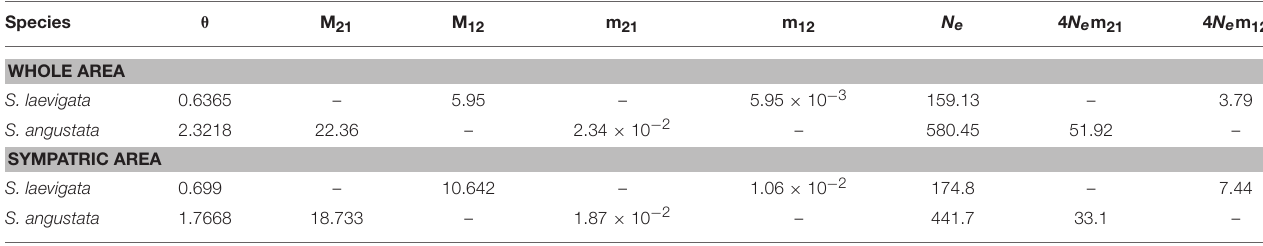
TABLE 3 | Effective population sizes ( N e ) and effective number of migrants between species (4 N e m) in S. angustata and S. laevigata , estimated by maximum likelihood. Species WHOLE